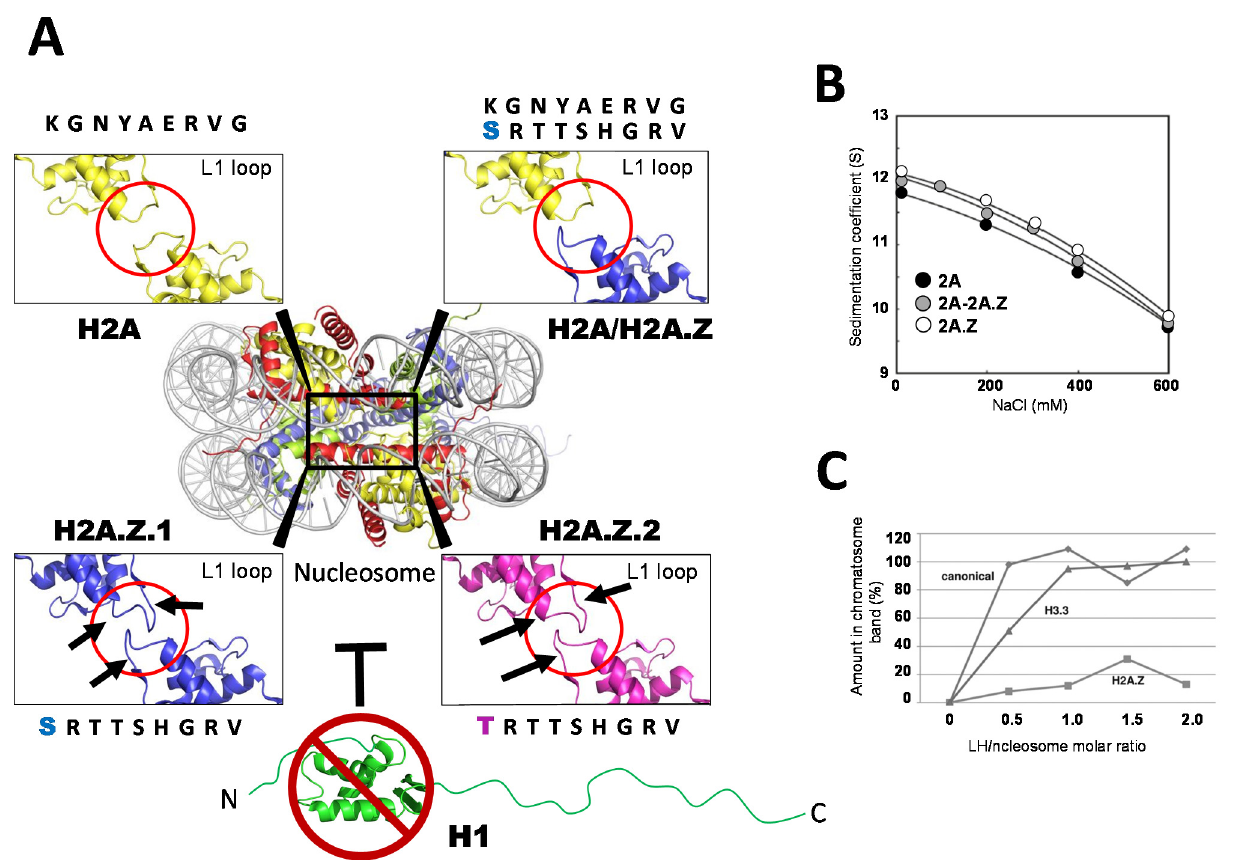
Figure 2. ( A ) Contacting regions, involving loop 1, of the histone fold for the two H2A histones present in the nucleosome. The details are shown for a homotypic nucleosome consisting of two canonical H2A histones (H2A), a heterotypic nucleosome consisting of a canonical H2A and an H2A.Z histone variant (H2A/H2A.Z), and two homotypic nucleosomes consisting of two H2A.Z.1 (H2A.Z.1) or two H2A.Z.2 (H2A.Z.2) variants. The loop 1 regions are highlighted in red and the black arrows to indicate the sites where differences are